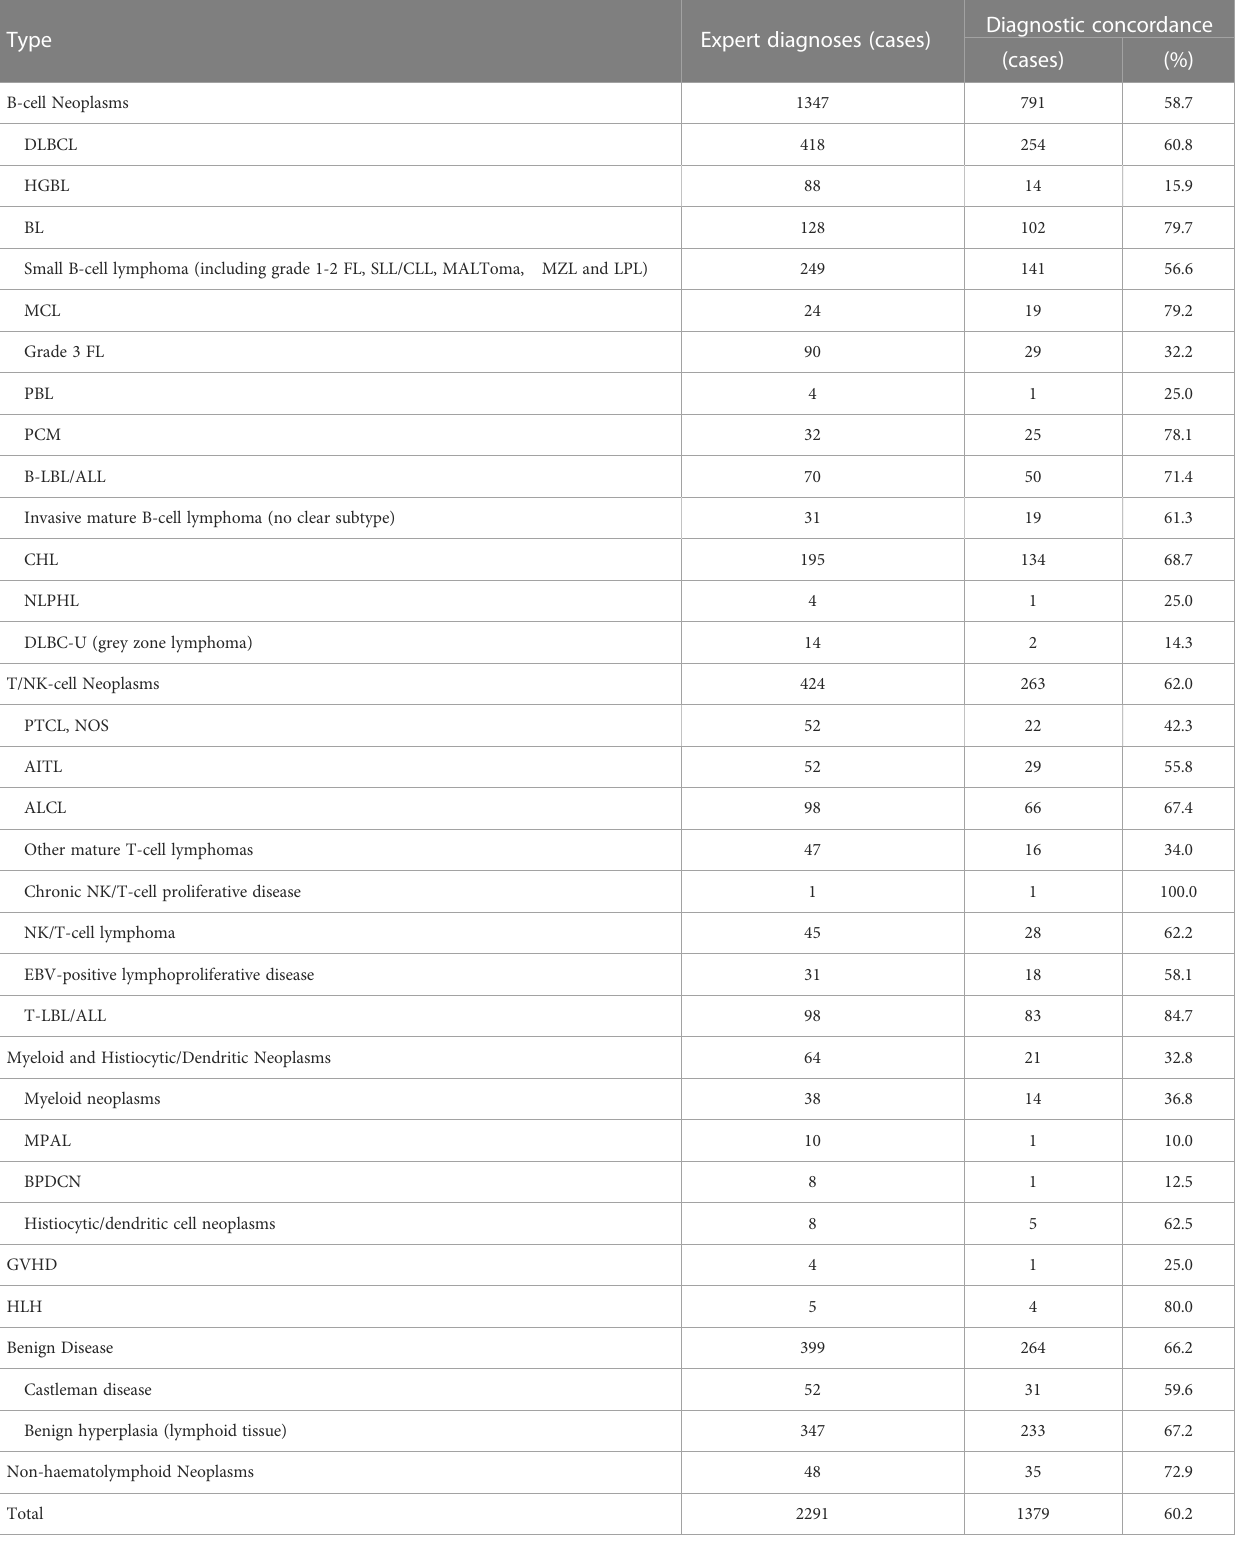
TABLE 1 Comparison of initial and expert diagnoses in 2291